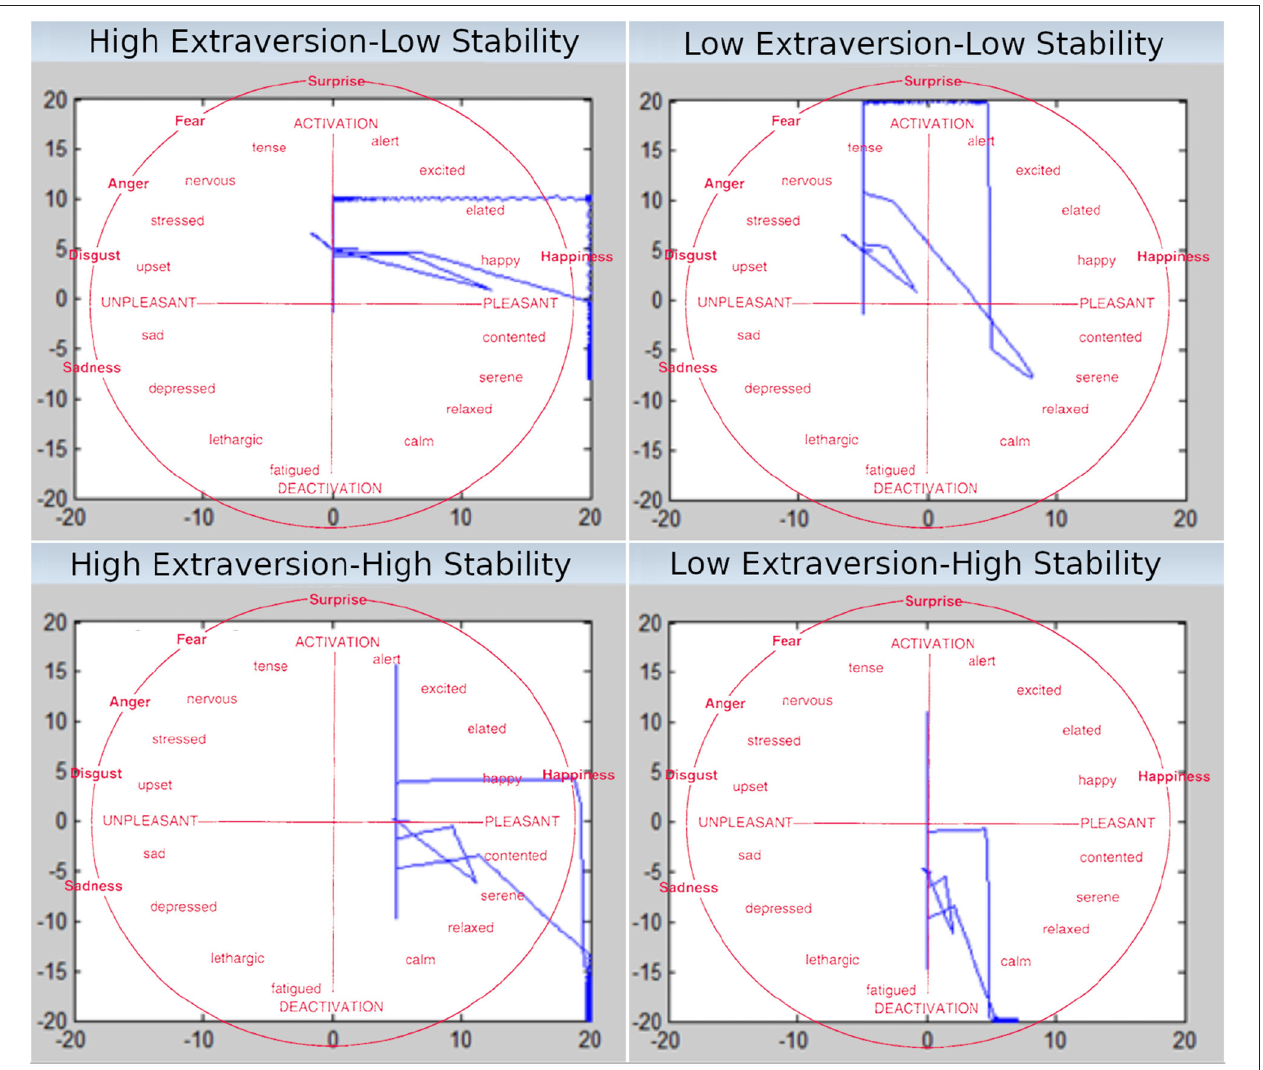
FIGURE 3 | Effect of the personality parameters on the time course of Valence and Arousal. The x dimension denotes Valence, the y dimension Arousal. The red overlaid text show the circumplex model of affect (Russell, 1980).